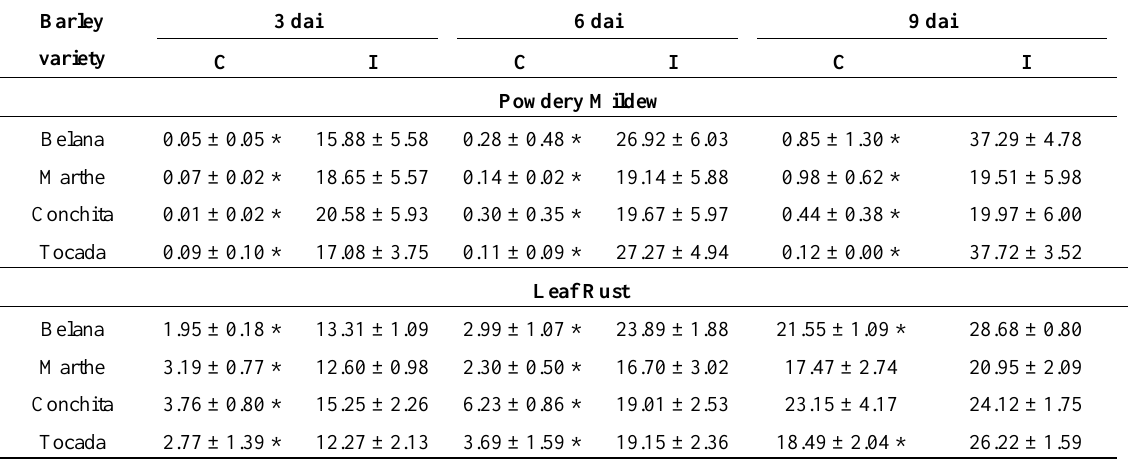
Table 3. Area of green fluorescence intensity (mm 2 ) of control (C), powdery mildew or leaf rust inoculated (I) barley leaves of the varieties Belana, Marthe, Conchita and Tocada at 3, 6 and 9 days after inoculation